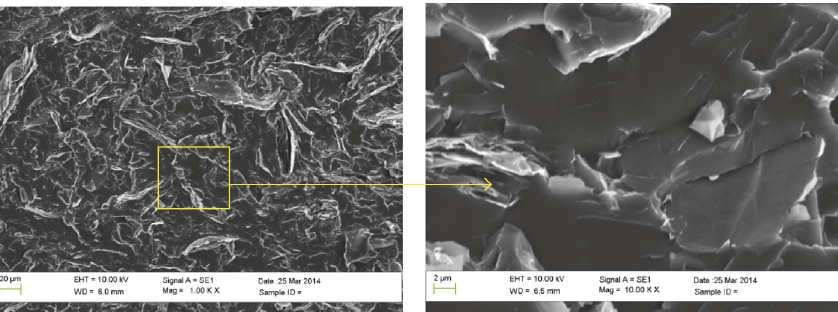
Figure 7: SEM images at low and high magnifications of fracture surfaces of PET-GNP nanocomposites containing 8 wt.% of GNP.